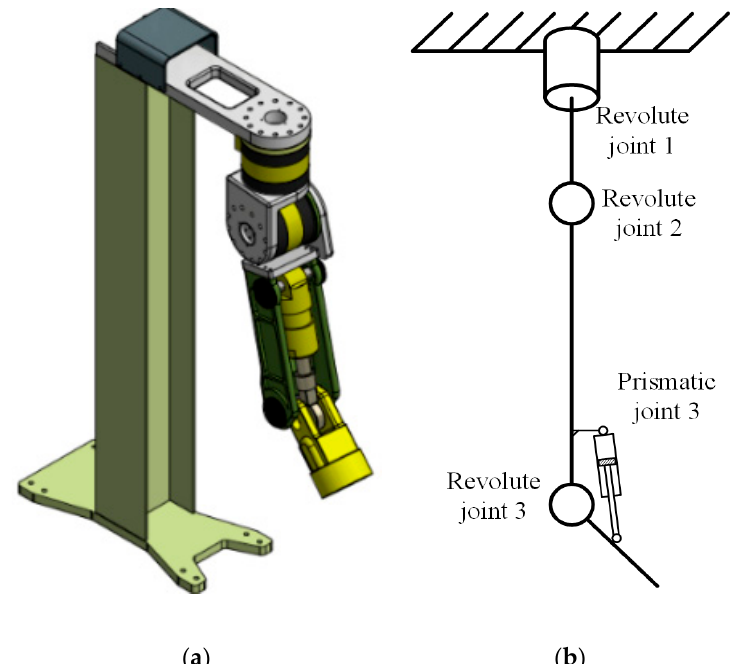
Figure 1. An overview of the 3-degrees of freedom (DOF) hydraulic manipulator: ( a ) 3D drawing; ( b ) principle drawing.